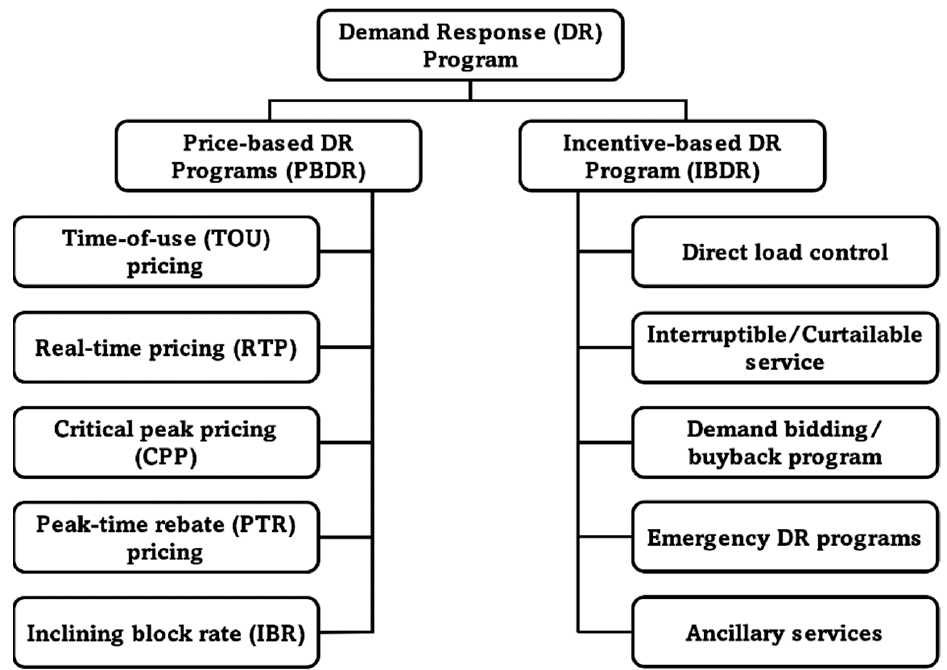
Figure 1. DR programs classification.